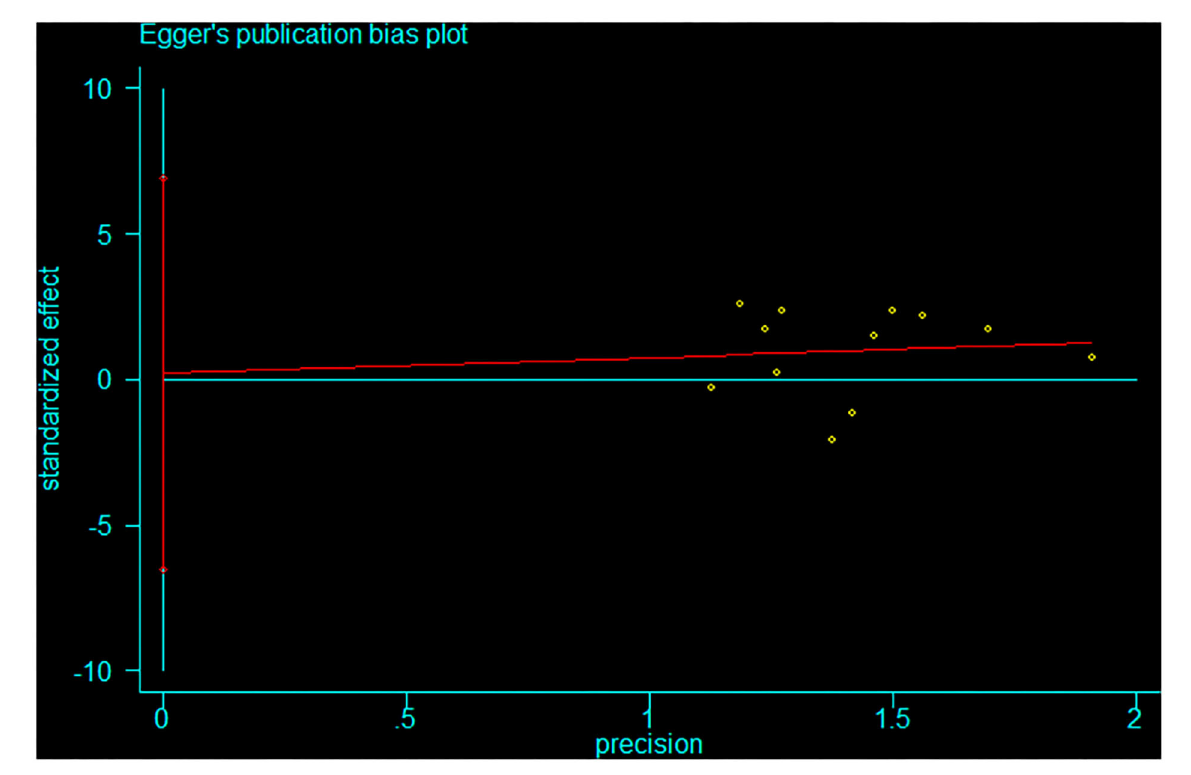
FIGURE5 Egger trial for overall complications after staged and concurrent cranioplasty and ventriculoperitoneal